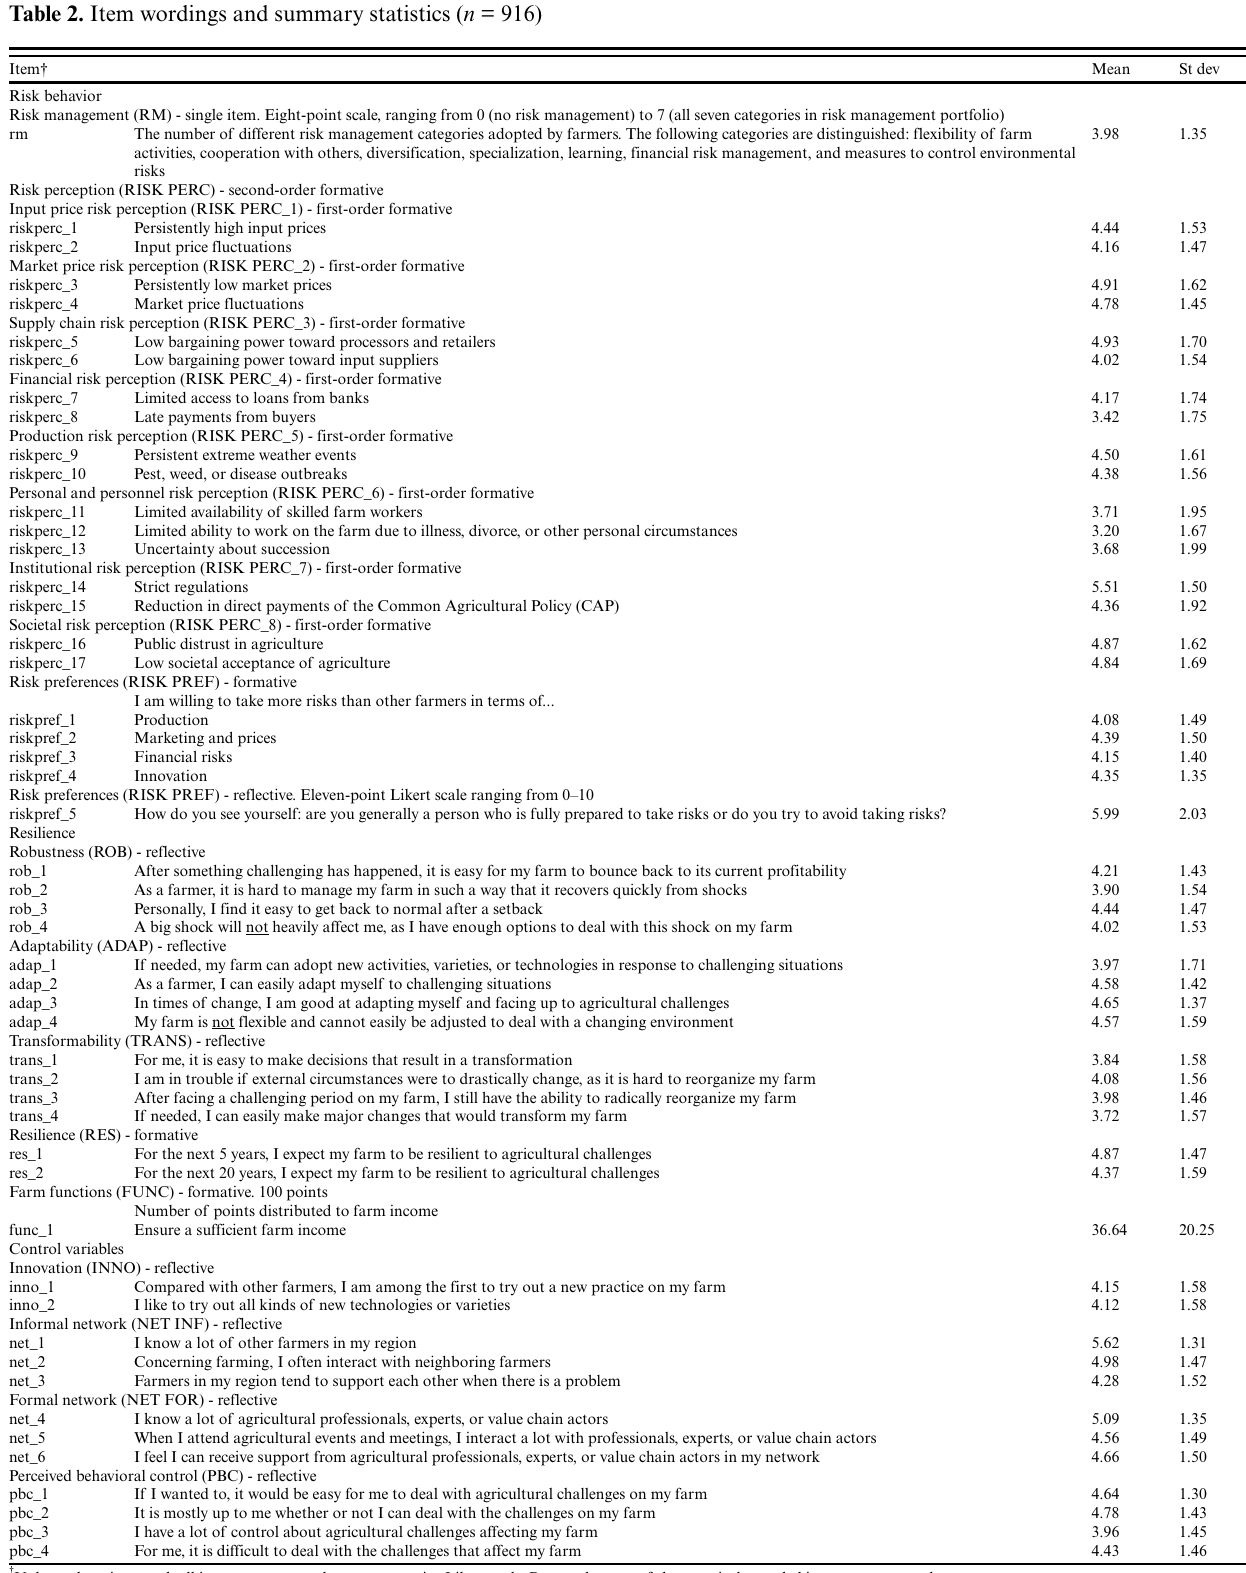
Table 2. Item wordings and summary statistics ( n = 916) Item† Mean St